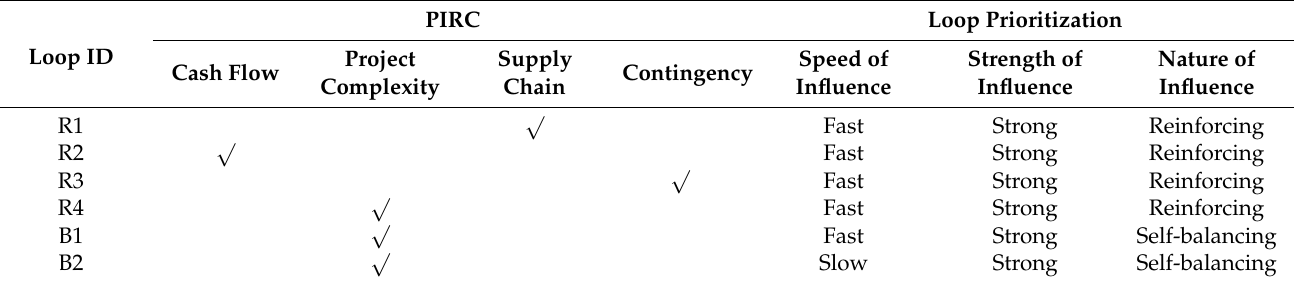
Table 5. Loop analyses results.